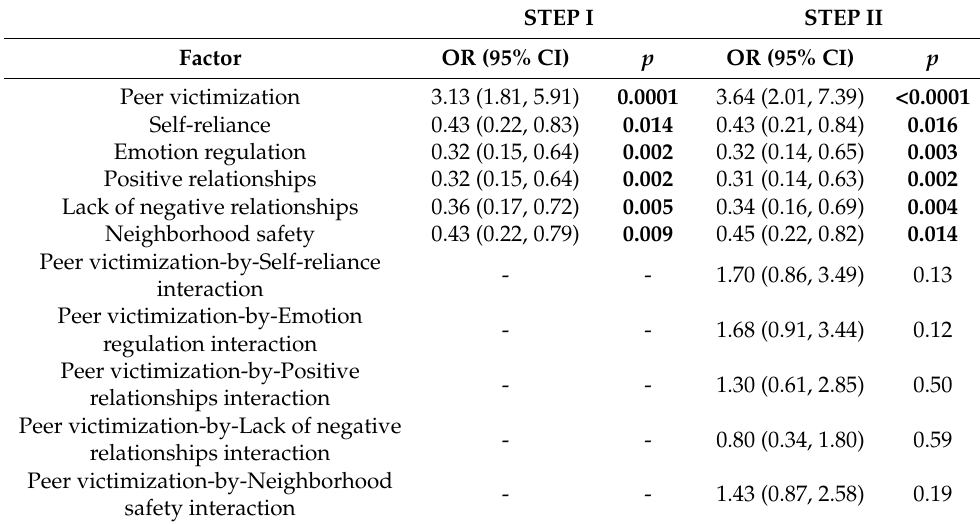
Table 3. Multiple hierarchical logistic regression with ASQ ≥ 1 as dependent